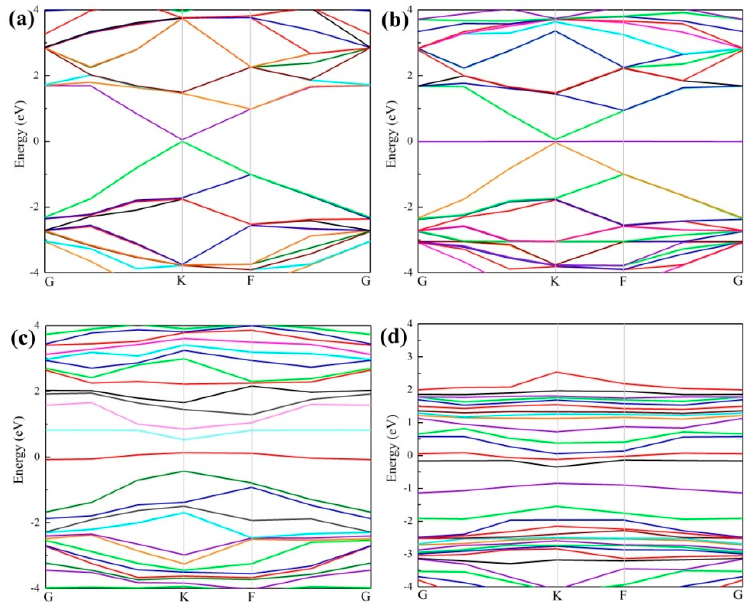
Figure 4. Band structure: ( a ) Intrinsic graphene; ( b ) intrinsic graphene with adsorbed Ag atom; ( c ) VG; ( d ) Ce-doped graphene with adsorbed Ag atom.